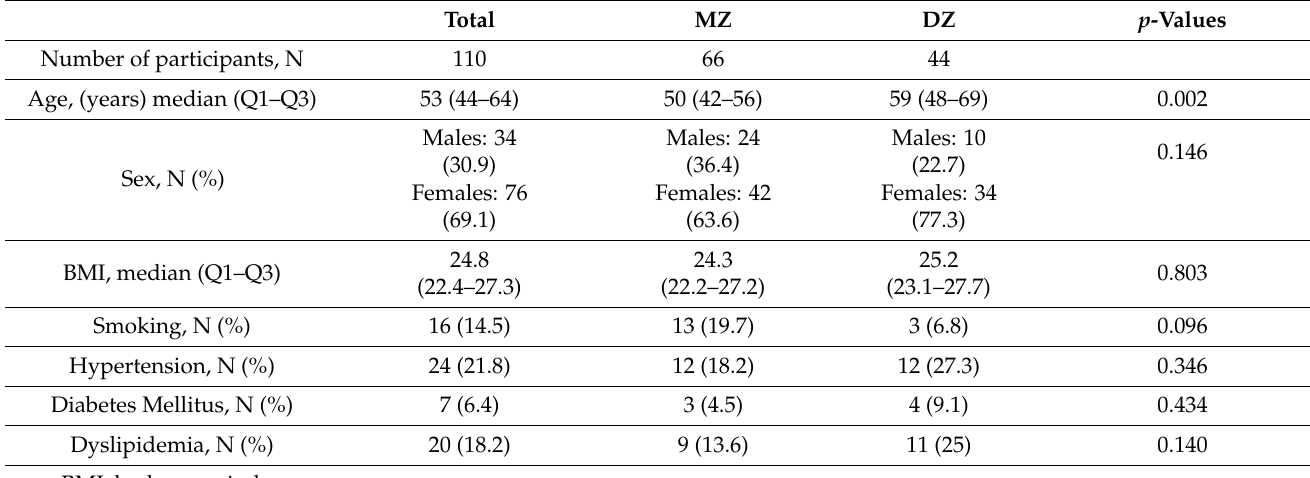
Table 1. Demographics and descriptive clinical characteristics of the study subjects. The continuous variables are expressed as the median (Q1–Q3) deviation. p -values of the Fishers’ exact test and the Mann–Whitney U tests for each parameter are shown.